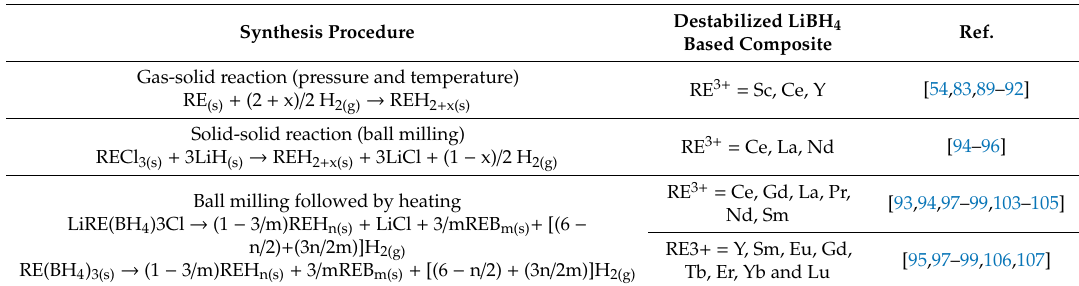
Table 6. Di ff erent synthesis routes of rare earth (RE)